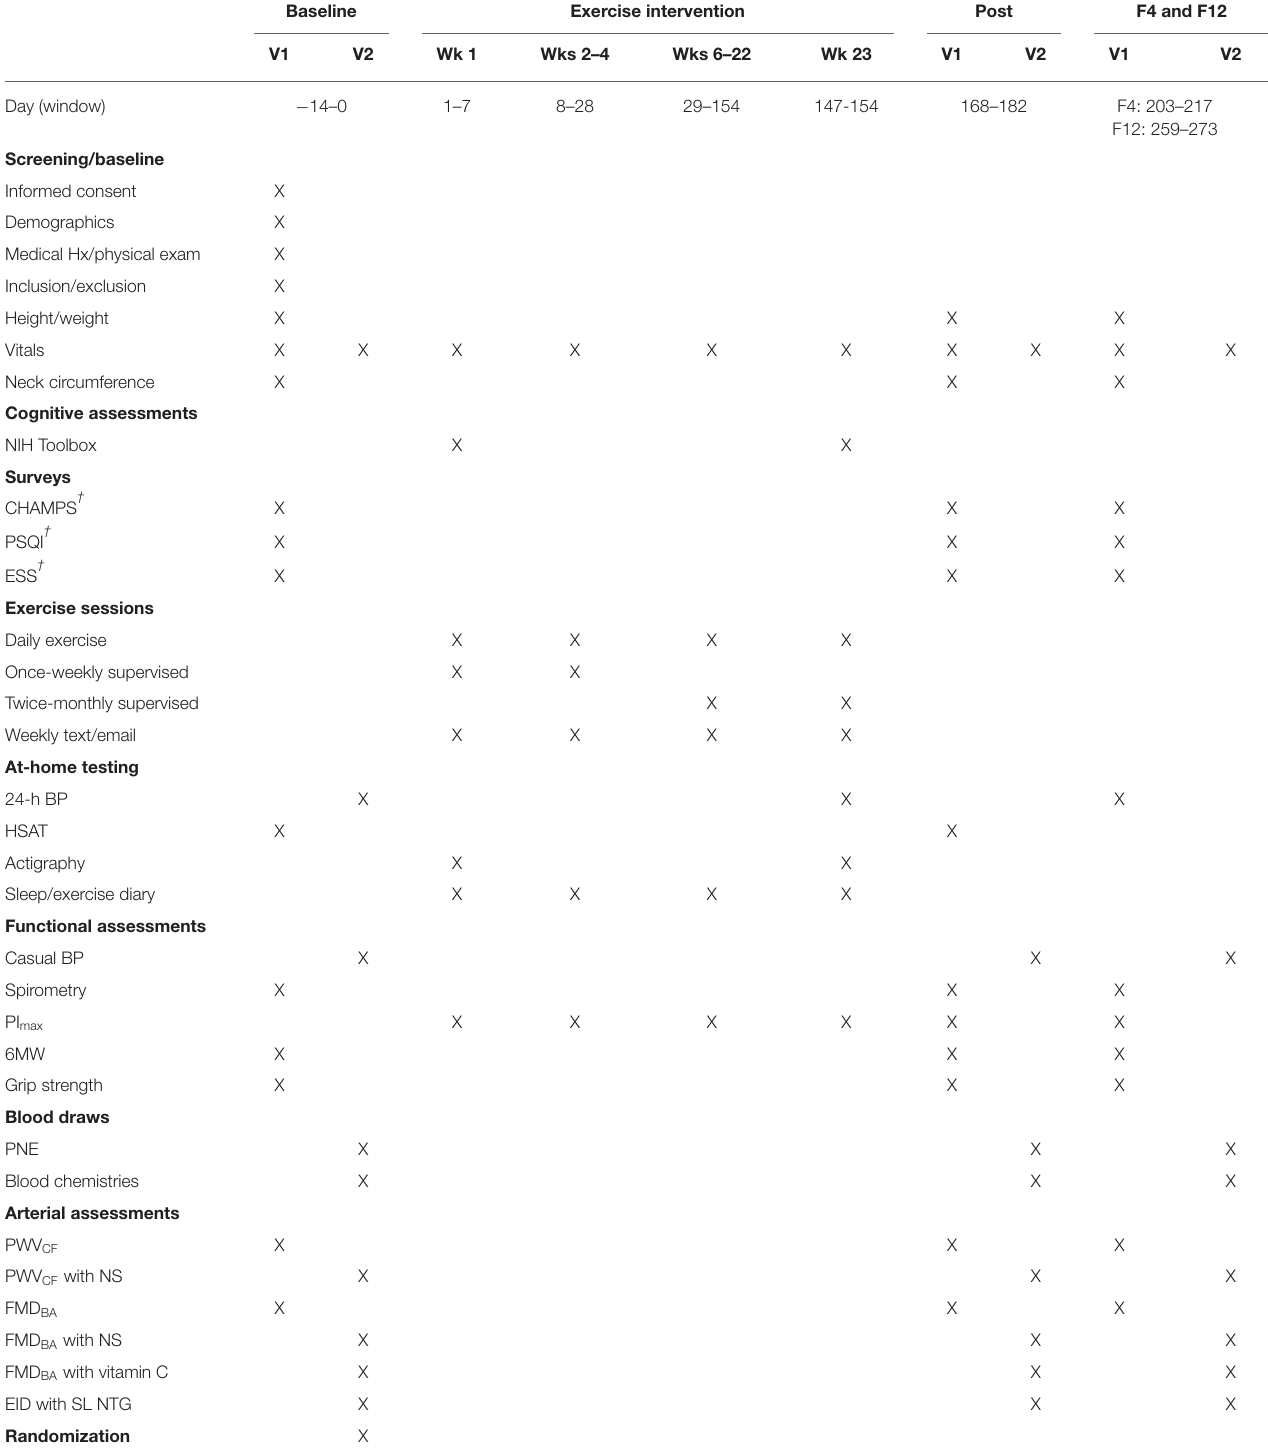
TABLE 2 | Schedule of